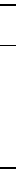
Table 2. Fluorescence lifetimes for ADAPT measured with the Time-Correlated Single Photon Counting (TCSPC) method after excitation with a 294 nm diode.